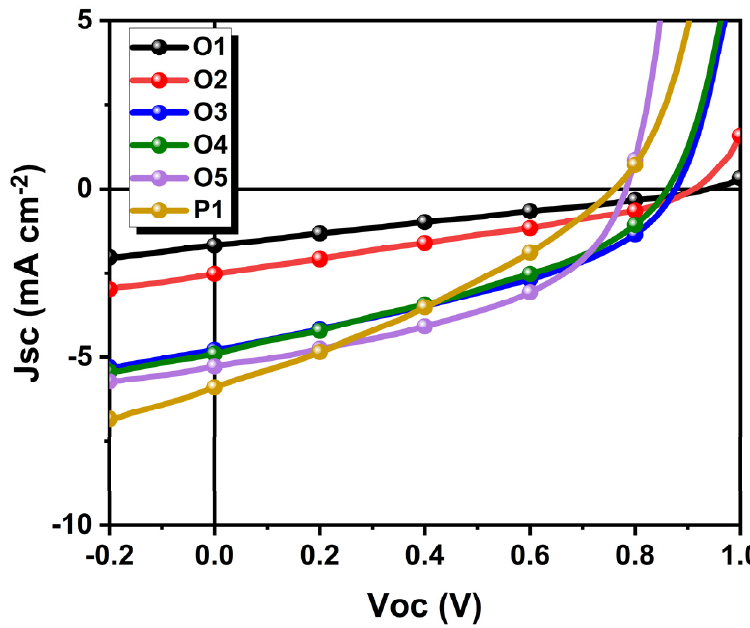
Figure 3. J - V curves of π -COs (or P 1): PC 70 BM based BHJ OPV devices. Table 2. BHJ device parameters of O s1~5 and P 1 a)